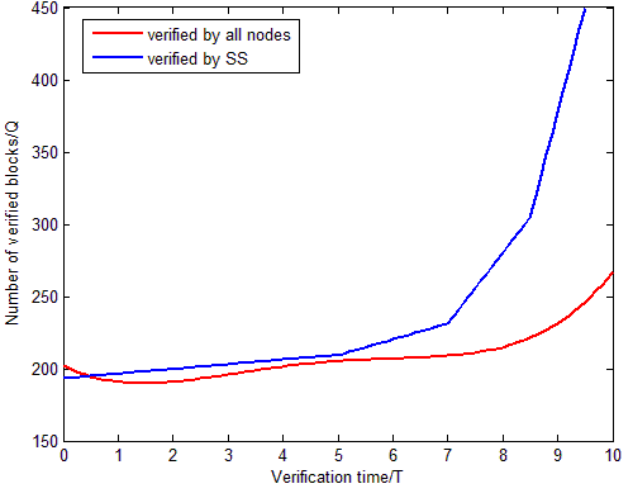
Figure 13. Verification efficiency comparison.